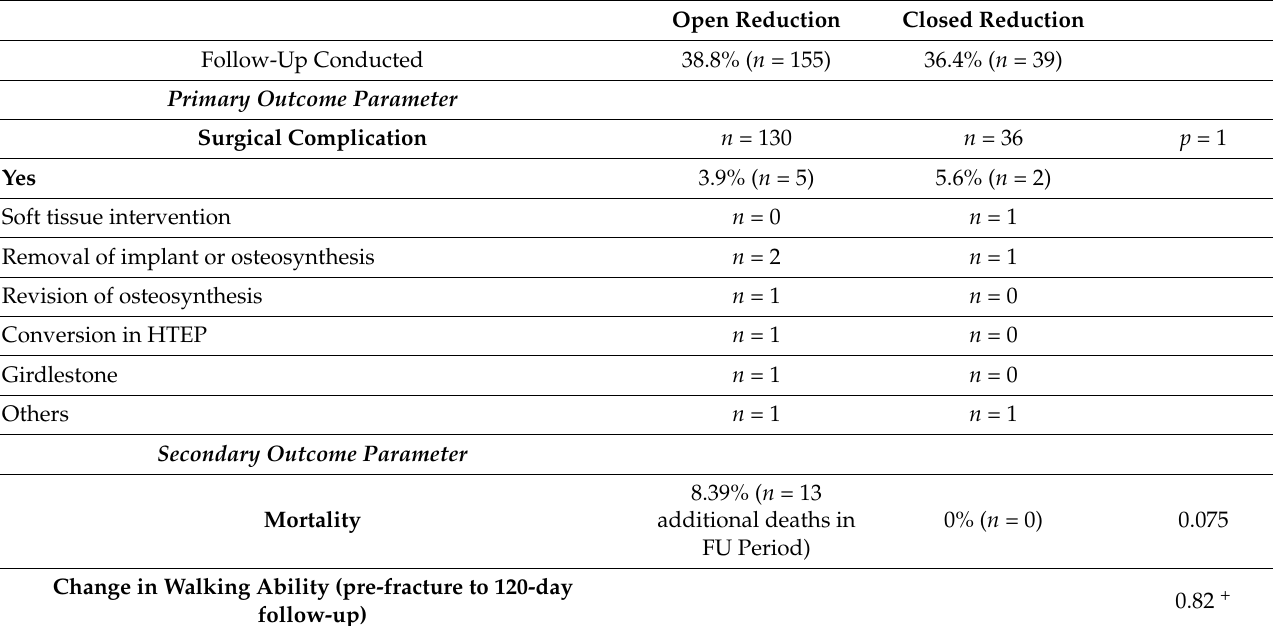
Table 3. Open reduction vs. closed reduction